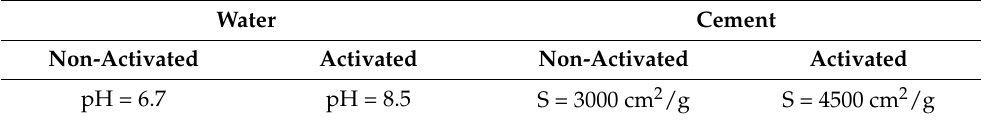
Table 5. General differences in the properties of activated and non-activated concrete components. Water Cement Non-Activated Activated